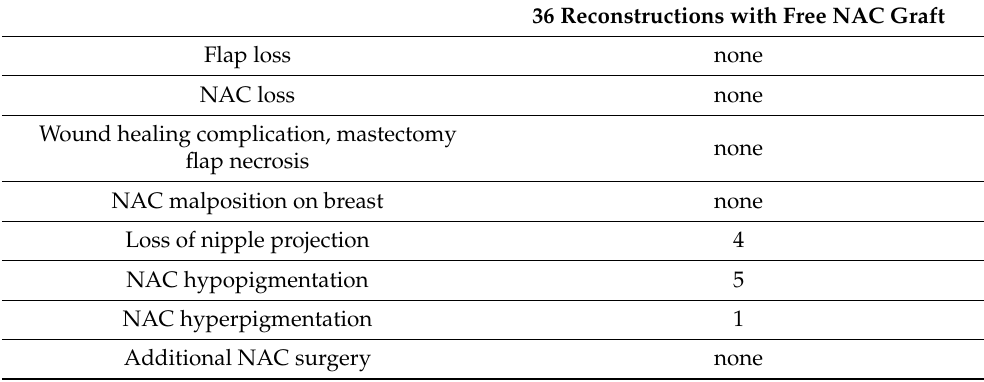
Table 2. Results after mastectomy, autologous breast reconstruction and free NAC